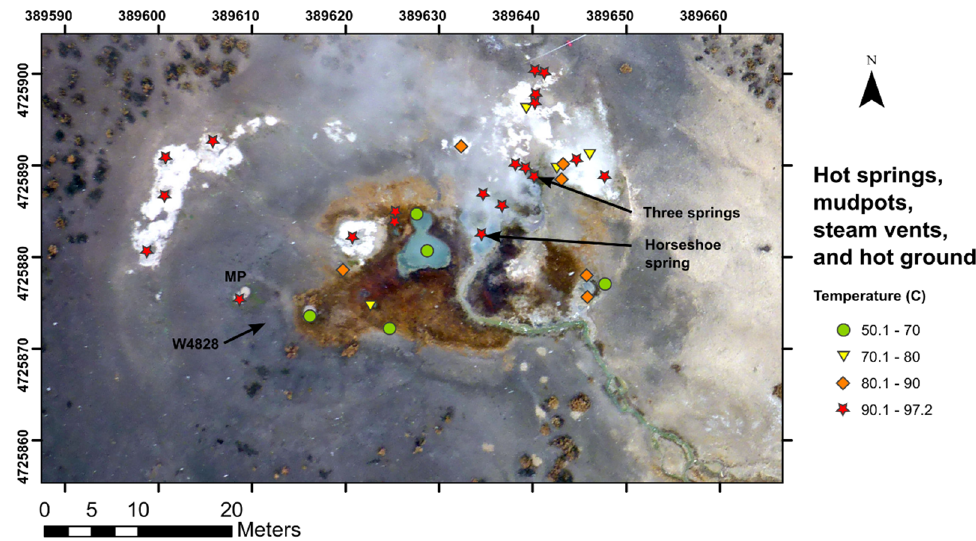
Figure 10. Most active springs, mud pots, and hot ground are concentrated in a 50 × 50 m area at Mickey Springs. No sinter is present in this area, which is located 5 m below most sinter features. Location of the TL sample W4828 are indicated, and the mud pot (MP), which erupted between March and May, 2014, resurfacing the area within a 3 m radius.